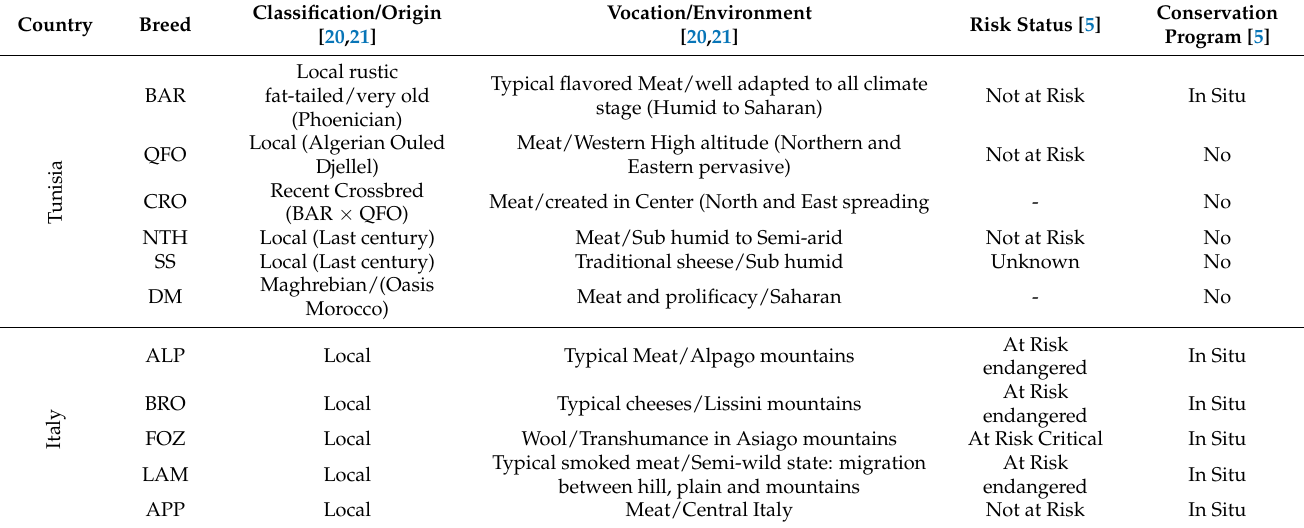
Table 1. Information about the sampled Tunisian and Italian locally adapted sheep breeds: Tunisian breeds: Barbarine (BAR), Queue Fine de l’Ouest (QFO), cross-bred BAR × QFO (CRO), D’man (DM), Sicilo-Sarde (SS), Noire de Thibar (NTH); Venetian breeds: Alpagota (ALP), Brogna (BRO), Foza (FOZ) and Lamon (LAM); Central Italian breed: Appenninica